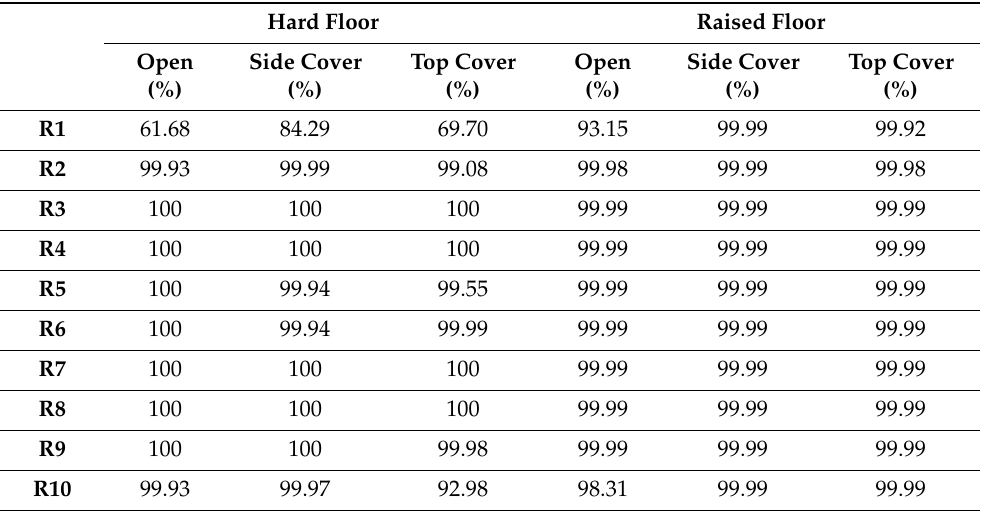
Table 5. Capture Index (CI) for the server racks in all setups with 100% supply flow rate. Hard Floor Raised Floor